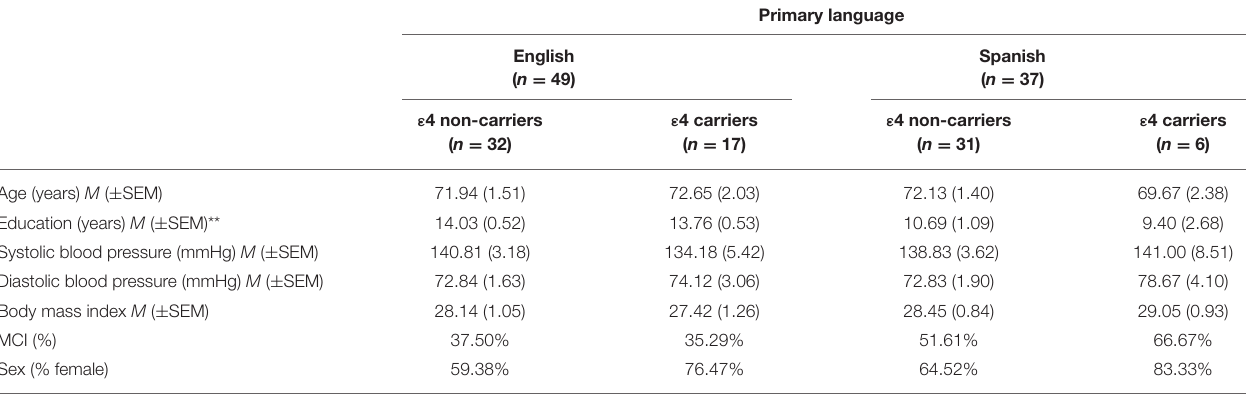
TABLE 4 | Participant demographics for Hispanics/Latinos organized by primary language and APOE ε 4 status.